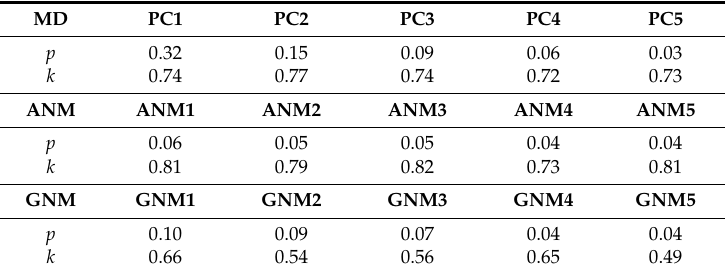
Table 1. Fraction of variance ( p ) and collectivity ( k ) of the first five Principal Component Analysis (PCA), ANM and GNM modes for the DNA octahedron.